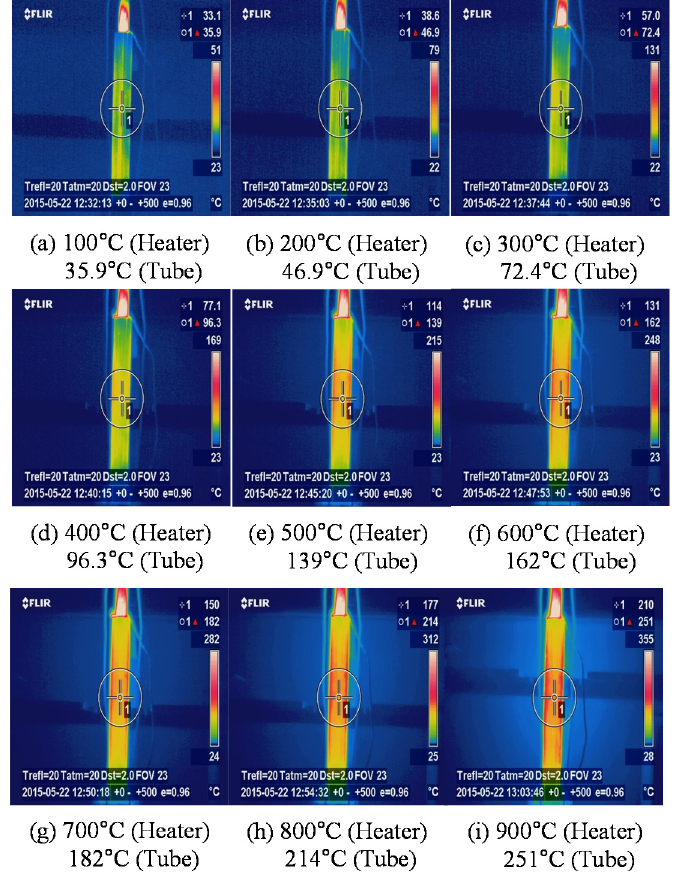
Figure 6. Thermal imaging contours captured by the thermo-graphic camera (T3-1 Model). ( a ) 100 °C heater ( b ) 200 °C heater ( c ) 300 °C heater ( d ) 400 °C heater ( e ) 500 °C heater ( f ) 600 °C heater ( g ) 700 °C heater ( h ) 800 °C heater ( i ) 900 °C heater.